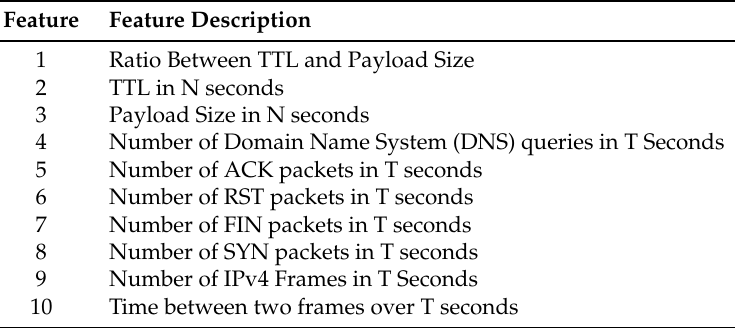
Table 2. Features extracted from Table